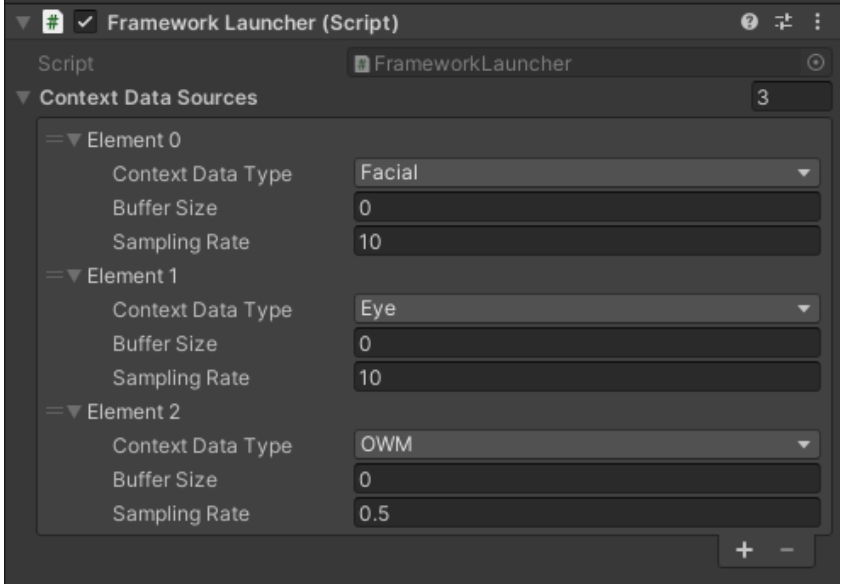
Figure 15. Configuration of the Framework Launcher script in Unity that starts and stops ManySense VR. In this example, the eye tracker, facial tracker, and OpenWeatherMap data managers have been enabled with specific buffer sizes and sampling